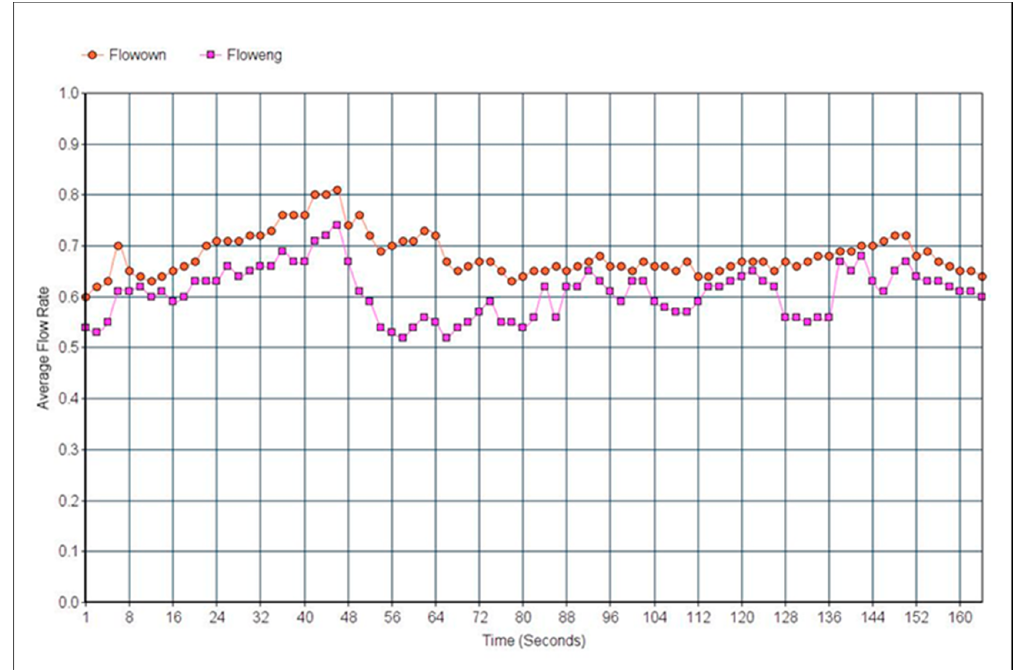
Figure 8. Average flow rate and reception flow time rates with 50% vehicle attacks (with IDS).